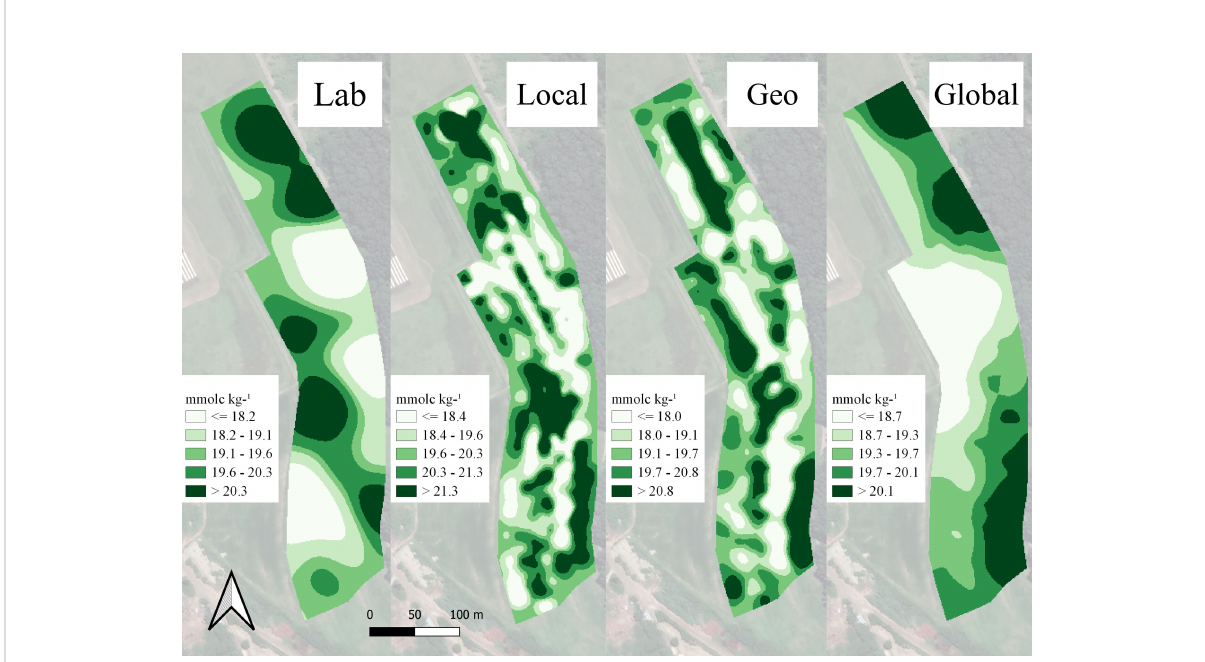
FIGURE 8 Maps of the fi ve quantiles obtained by ordinary kriging of calcium (Ca) values of laboratory samples analysis (Lab) and the prediction models using three different strategies of calibration: only in- fi eld samples (local), adding samples from the same geological region (geological), and adding samples from different geological regions